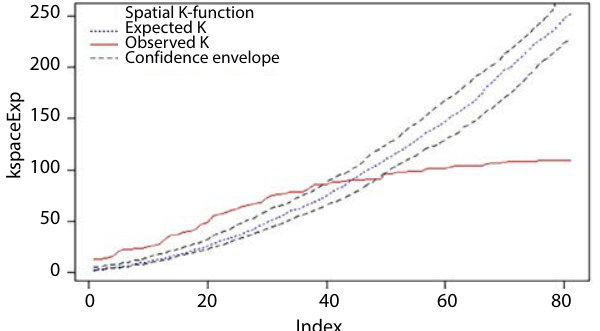
Figure 4: Spatial K-function analysis for uniformity of distribution of ASF outbreaks in South Africa